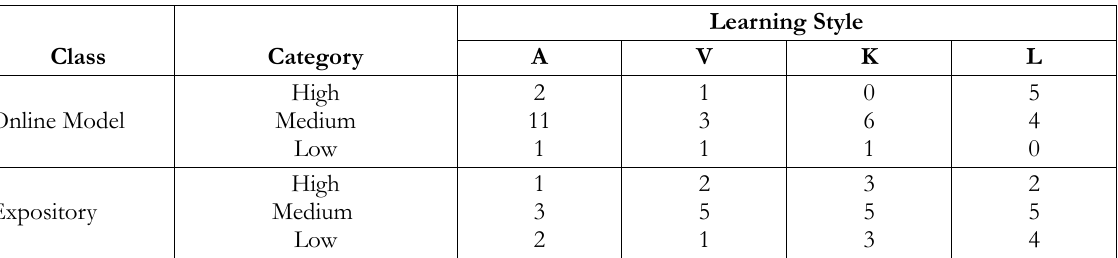
Table 9. Mathematic connection Skill of the Students According to the Learning Style